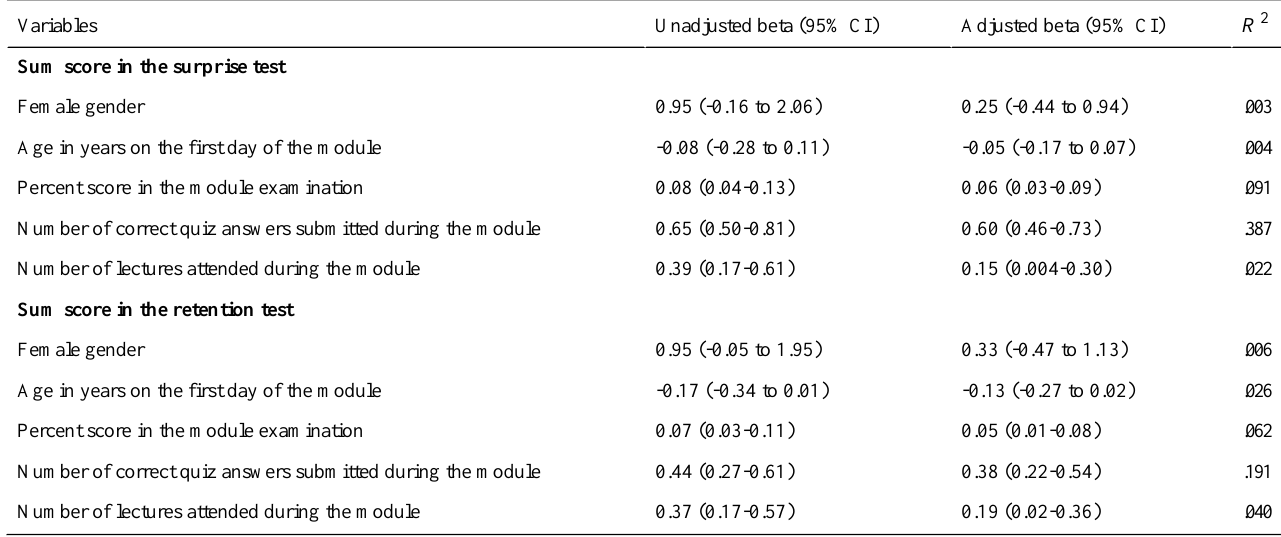
Table 2. Predictors of student performance in the surprise and retention tests ( R 2 , variance